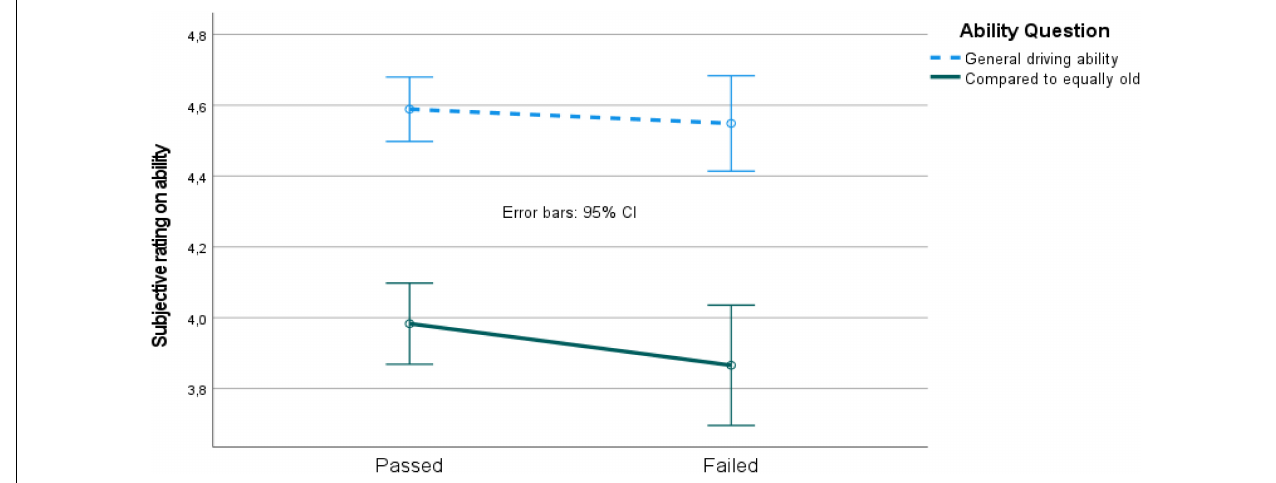
FIGURE 3 | Ability ratings for passed vs. failed driving simulator test participants. CI, confidence interval.